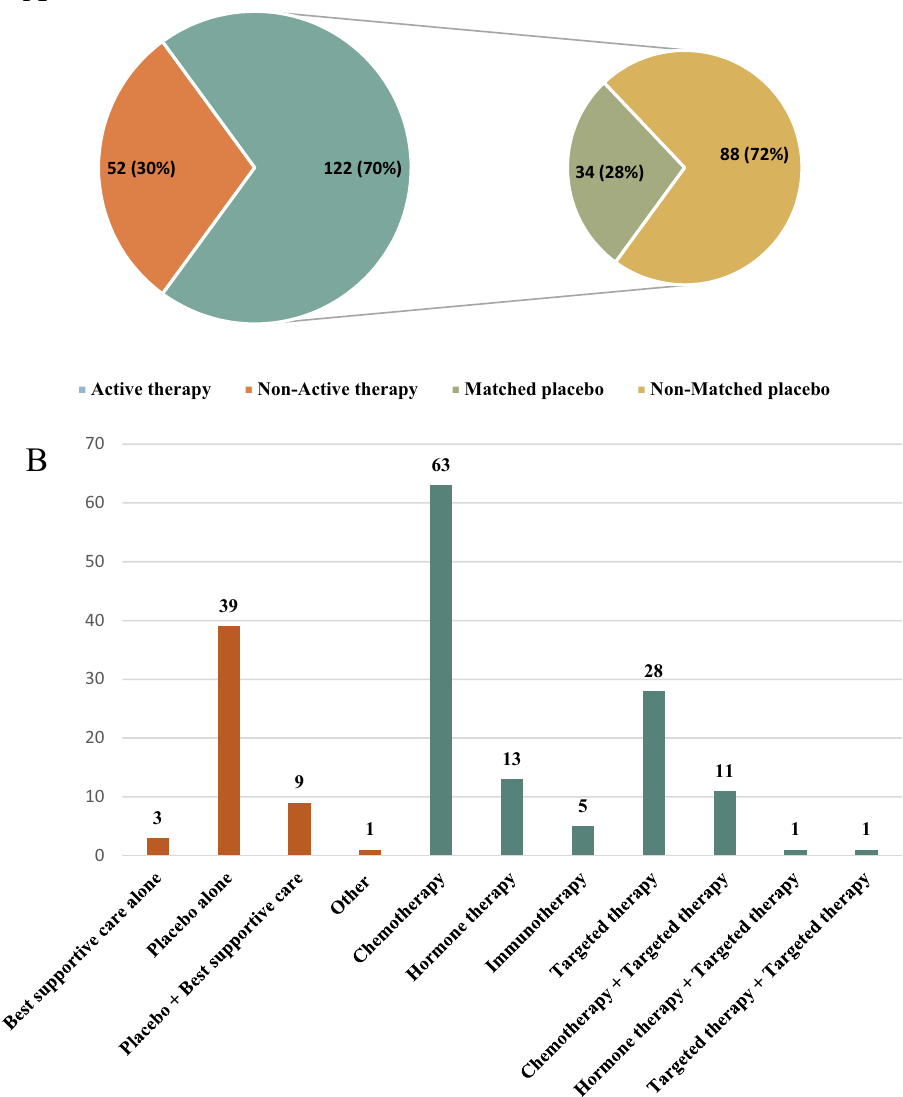
Figure 2. Types of control group therapy. ( A ) Of 174 RCTs analyzed, 70% had an active therapy and 30% had non-active therapy in the control arm. Among RCTs with active therapy in the control arm, 28% were matched placebo (e.g., active therapy plus placebo in the control arm vs. the same active therapy plus an additional drug in the experimental arm). ( B ) Active therapy group was defined as control arm comprising an active anticancer drug such as chemotherapy, hormone therapy, immunotherapy and/or targeted therapy and non-active therapy group was defined as control arm comprising placebo and/or best supportive care alone. Other = Granulocyte– macrophage colony-stimulating factor. RCTs Randomized Controlled